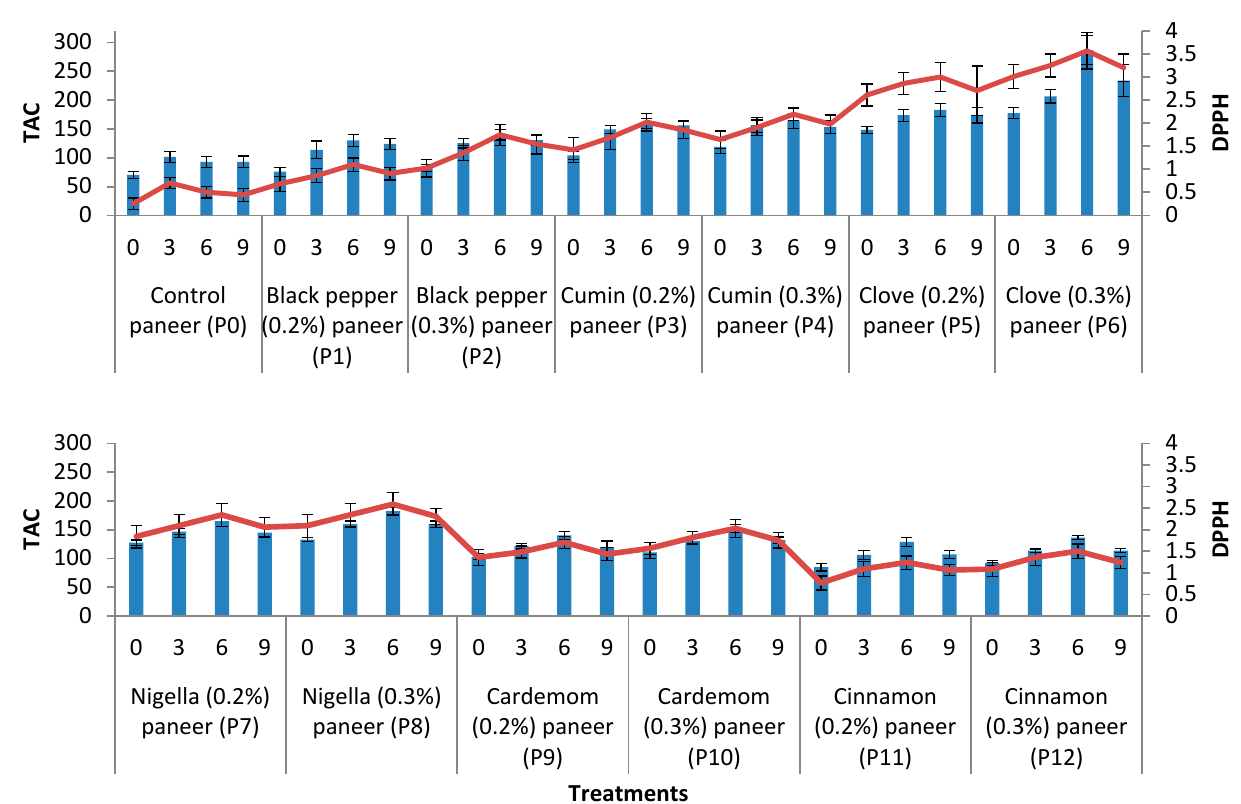
Figure 5. Total antioxidant activity (TAC, means ± SD) (blue bar, mg TE/100 g) and DPPH radical scavenging activity (means ± SD, red line, mM TE/g) of spicy paneer during storage at 5 °C.